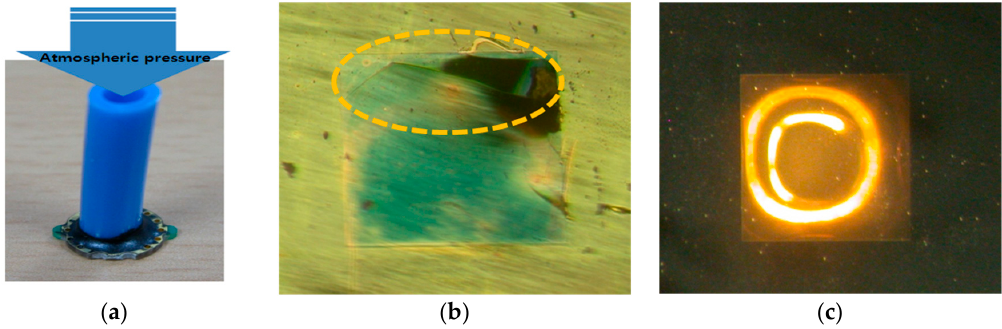
Figure 13. Comparison of the ability of a membrane to withstand pressure with and without the PI coating. ( a ) Sample made to measure ability to withstand pressure. ( b ) Without PI coating, membrane appears broken at 1.01 bar. ( c ) With PI coating, membrane appears unbroken even at 9 bar.